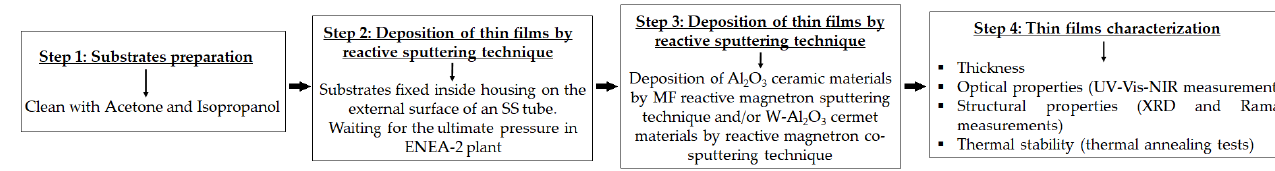
Figure 2. Diagram with detailed descriptions of all the steps involved to realize and characterize the